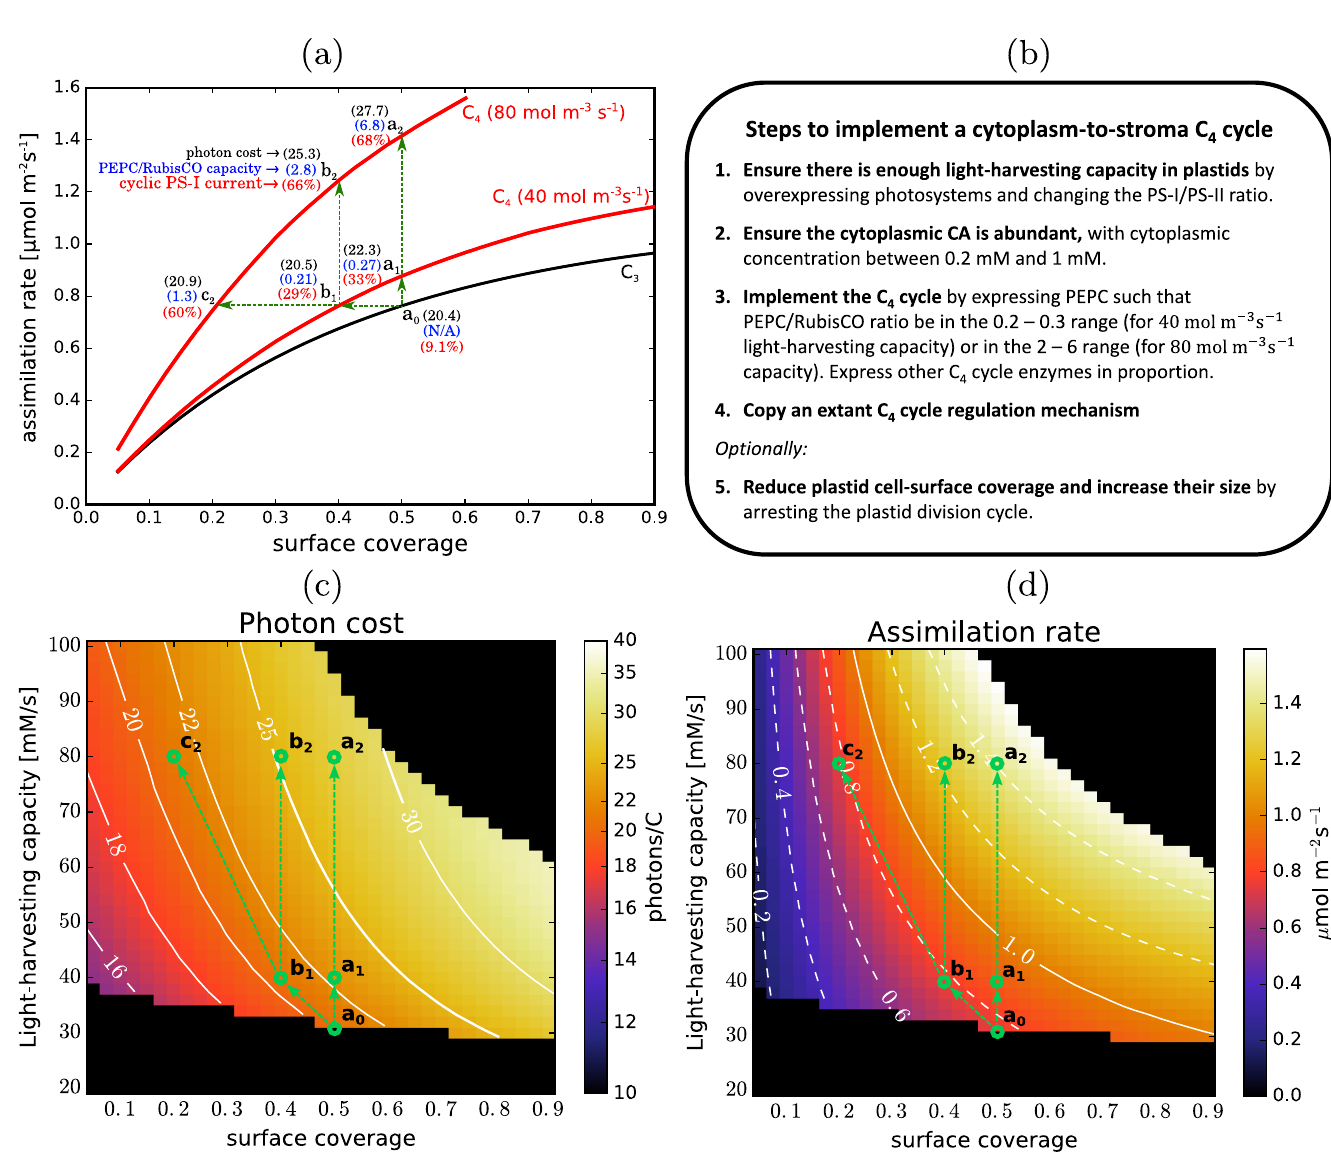
Fig 8. Altering chloroplast surface coverage and light harvesting capacity. (a) The assimilation rate per cell surface area as a function of chloroplast surface coverage in the case of C 3 photosynthesis (black line) and C 4 photosynthesis at the C 4 cycle activity levels where light-use reaches 40 mol m -3 s -1 and 80 mol m -3 s -1 thresholds (red lines). The numbers in parentheses show the respective photon costs (black), PEPC-vs-RubisCO carboxylation capacity ratios (blue), and the fraction of current through PS-I due to cyclic electron transfer (red). Green arrows illustrate organism modification strategies discussed in the main text. Parameters as in Fig 4. (b) An outline of a recipe for making a functional C 4 photosynthesising prototype. (c) and (d): The photon cost and assimilation rate as functions of the surface coverage and threshold light-use in C 4 photosynthesis. The panels are a remapping of Fig 4 with an alternate y-axis. Level-lines are in white. In the dark region at the bottom the light-use is below the requirements of C 3 photosynthesis. The top right dark region corresponds to PEPC levels beyond those simulated. The green circles and arrows mark the modification strategies shown in